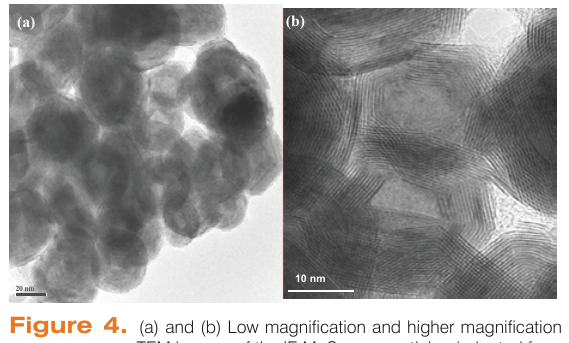
Figure 4. (a) and (b) Low magnification and higher magnification TEM images of the IF-MoS nanoparticles (adapted from 2 Ref. 42)